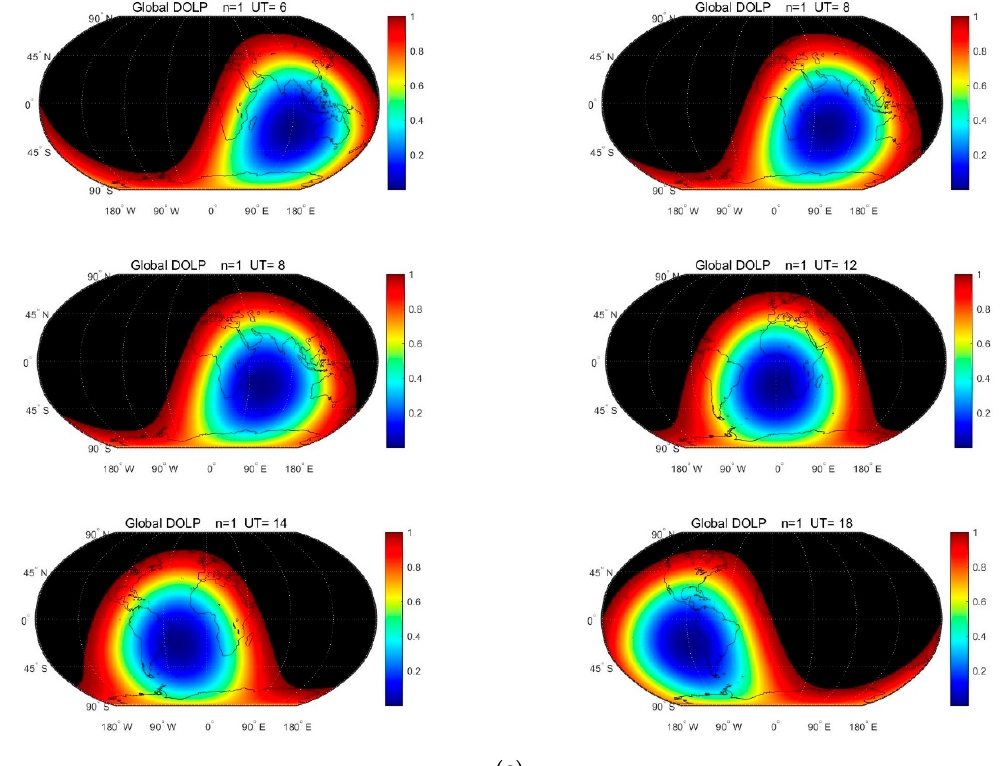
Figure 6. Theoretical simulation of the global polarization field and verification of a single-point sky polarization: ( a ) ground observation geometry; ( b ) actual observation results in different areas; ( c ) global polarization simulation (upper: spring, summer; lower: autumn, winter); ( d ) annual variation in the global skylight polarization field (12:00 GMT); ( e ) diurnal variation in the global skylight polarization field (summer solstice, GMT). ( a ) Observation geometry and ( b ) our results in China as well as those obtained by Pust and Shaw in the United States [9].